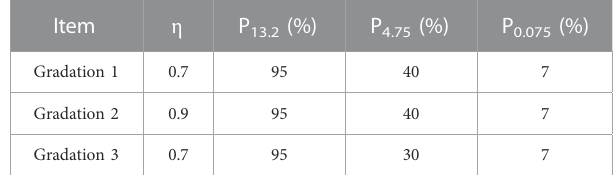
TABLE 11 Gradation design